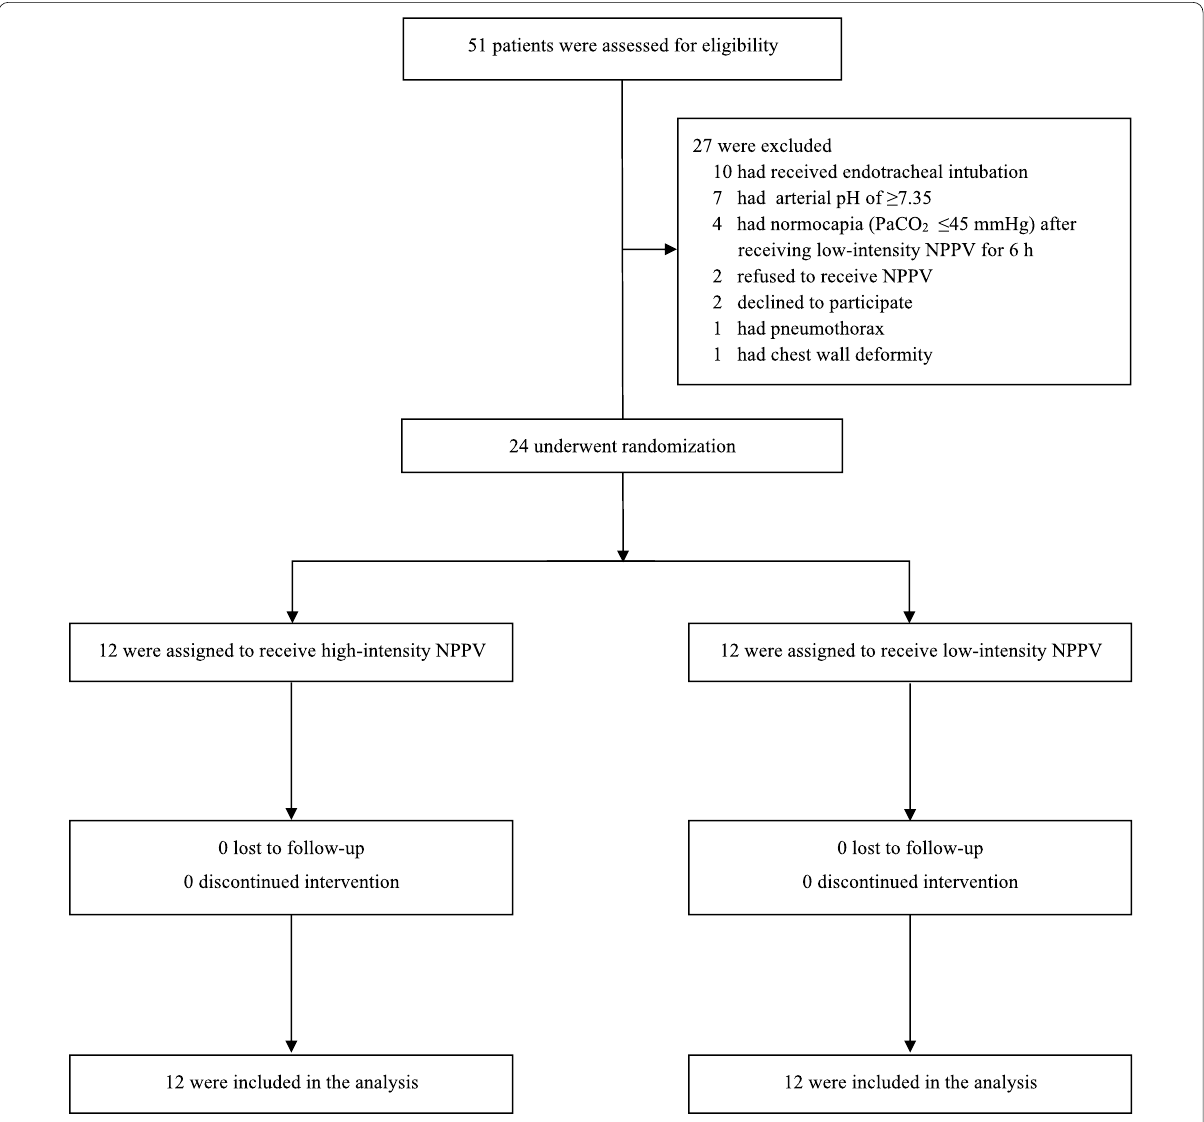
Fig. 1 Screening, randomisation, and analysis. PaCO 2 arterial carbon dioxide tension, NPPV noninvasive positive pressure